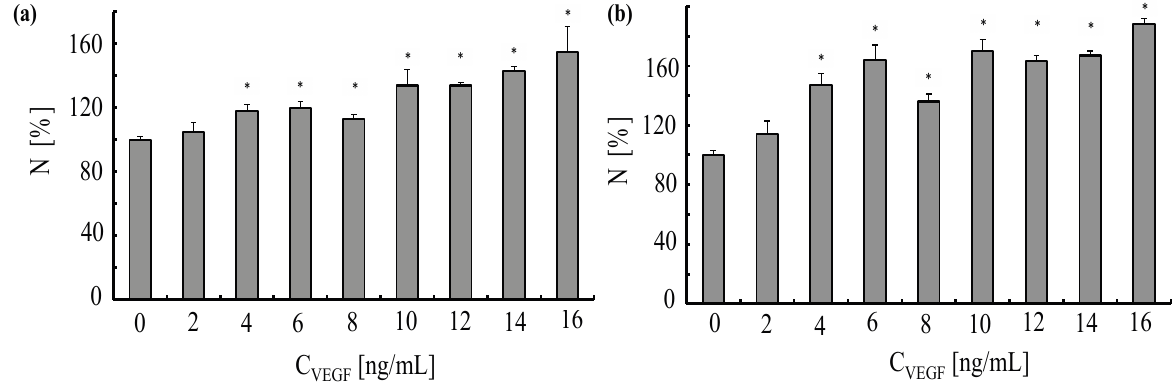
Figure 14. Response of human umbilical vein endothelial cells to vascular endothelial growth factor. The endothelial cells were plated in 96-well plates (5000 cells/well) one day before planned experiments. The cells were exposed for 24 h ( a ) and 48 h ( b ) to different concentrations C VEGF of VEGF. The normalized numbers of cells N in culture were evaluated by performing a proliferation test. Data correspond to the mean value ± standard deviation obtained from n = 4 experiments, * p < 0.001 (versus control value, no